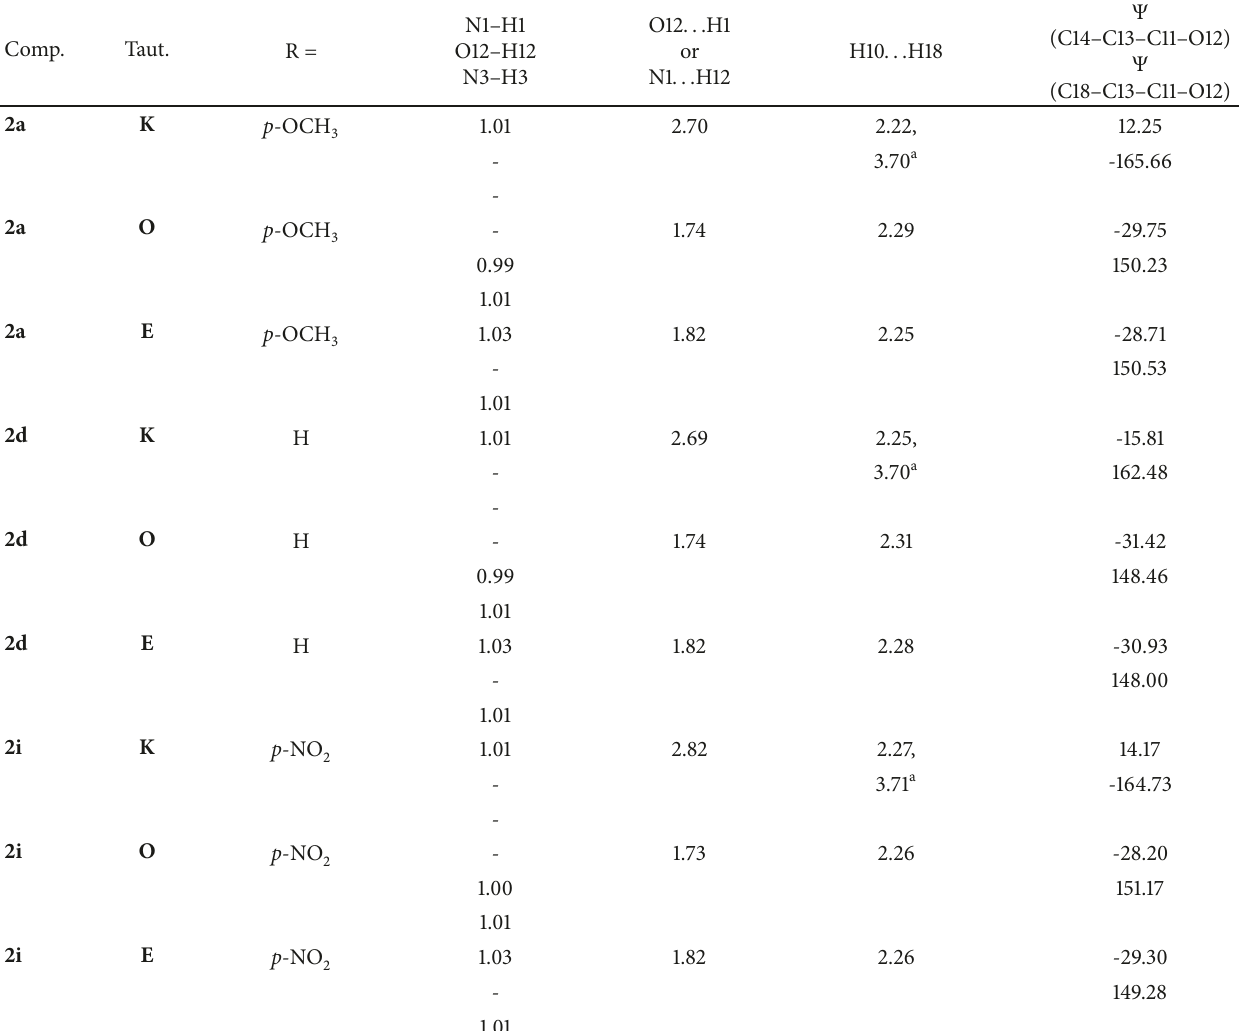
Table 3: Optimized (MP2/6-311+G(d,p)) bond lengths [˚A] and dihedral angles [deg] for 2-phenacylbenzimidazoles and their tautomers.